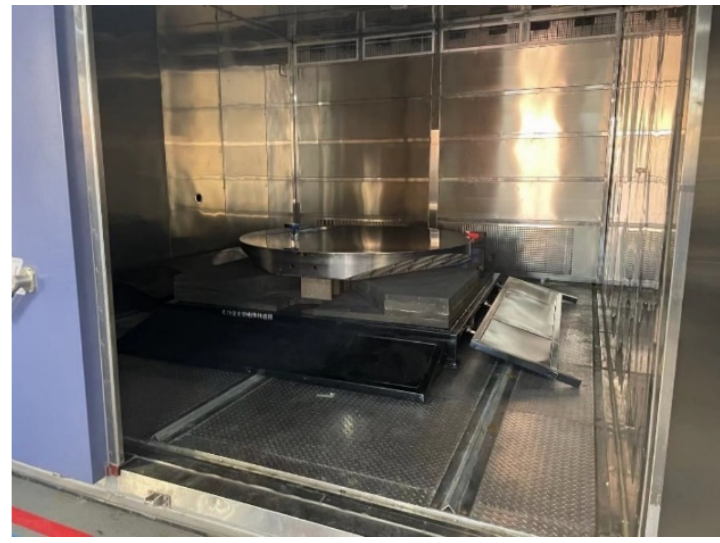
Figure 23. Temperature test.